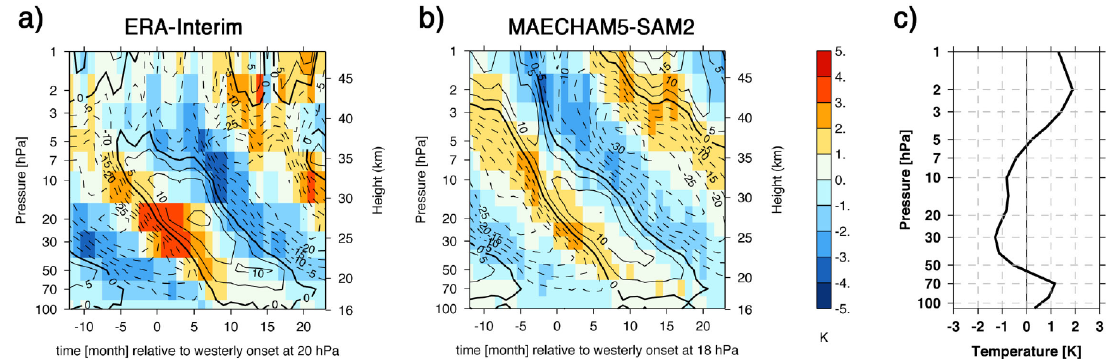
Figure 2. Residual temperature anomalies induced by the QBO in (a) the ERA-Interim reanalysis and (b) the QBO-nudged MAECHAM5- SAM2 simulation between 5 ◦ N and 5 ◦ S. Composited for the years 1996–2006 relative to the onset of residual westerlies at 20hPa and 18hPa, respectively. Black contours denote the residual zonal mean zonal wind, where dashed lines represent easterlies. Contour interval is 5ms − 1 . The difference between the climatological averaged temperature profiles of the QBO-nudged simulation and the control experiment (QBO − CTL) is shown in (c)